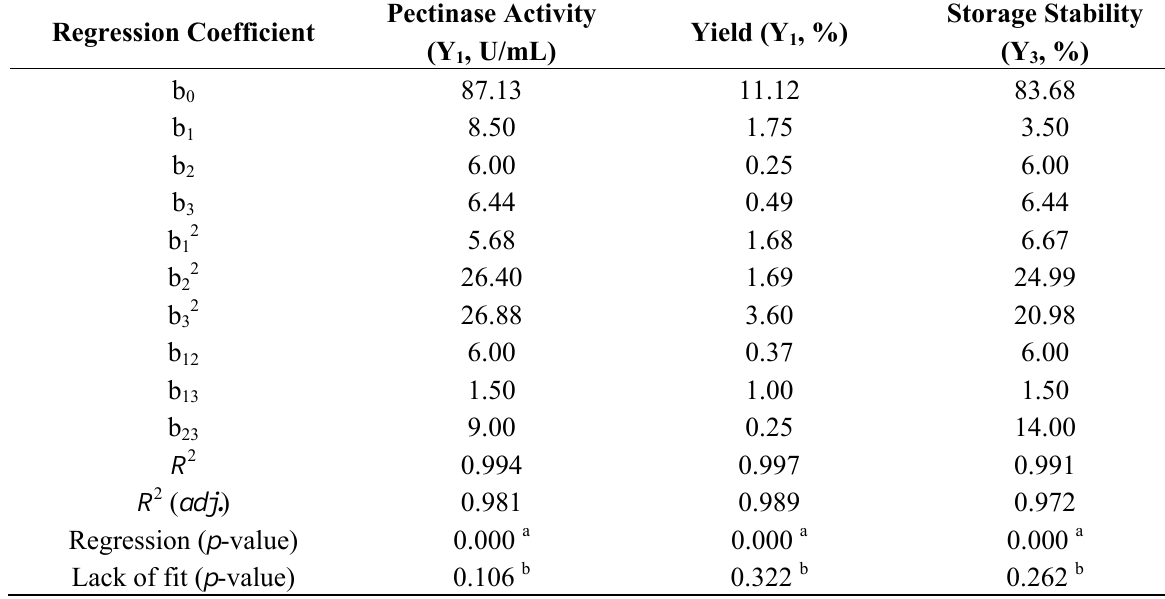
Table 1. Regression coefficients R 2 , adjusted R 2 and probability values of the response surface models.